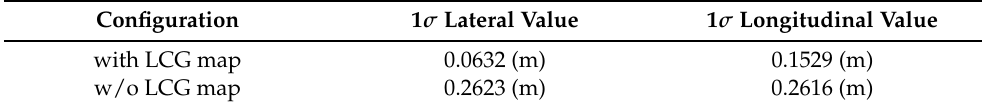
Figure 10. Frequency distribution of the lateral ( left histogram ) and longitudinal ( right histogram ) estimation error, comparing the results when the maps are combined with the onboard sensors (red bars) or when they are not exploited (blue bars). Table 3. Comparison of the 1 σ standard deviations for the lateral and longitudinal estimation errors when the LCG maps data are included or not included.